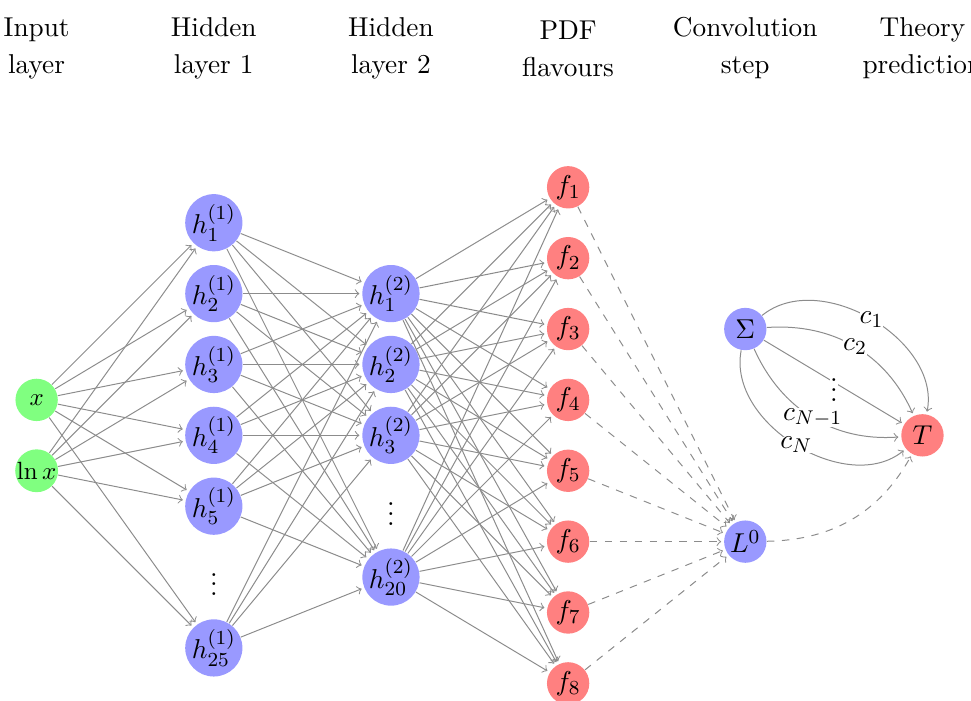
Figure 1 . Schematic depiction of the SIMUnet methodology. The input nodes (shown in green) are Bjorken- x and its logarithm. The forward pass through the deep hidden layers (blue) are performed as in the NNPDF4.0 methodology [2] to yield the output PDFs at the initial scale (red). The initial scale PDFs are then combined in the initial scale luminosity L 0 , defined in eq. (2.3). The initial scale luminosity is then convoluted with the pre-computed FK-tables Σ (shown in blue) to obtain the theoretical prediction T (shown in red), which enters the figure of merit (3.1), which is minimised in the fit. The Σ dependence on the parameters { c n } is fed into theoretical prediction T via the trainable edges of the combination layer. All trainable edges are shown by solid edges and are thus learned parameters determined through gradient descent, while dashed edges are